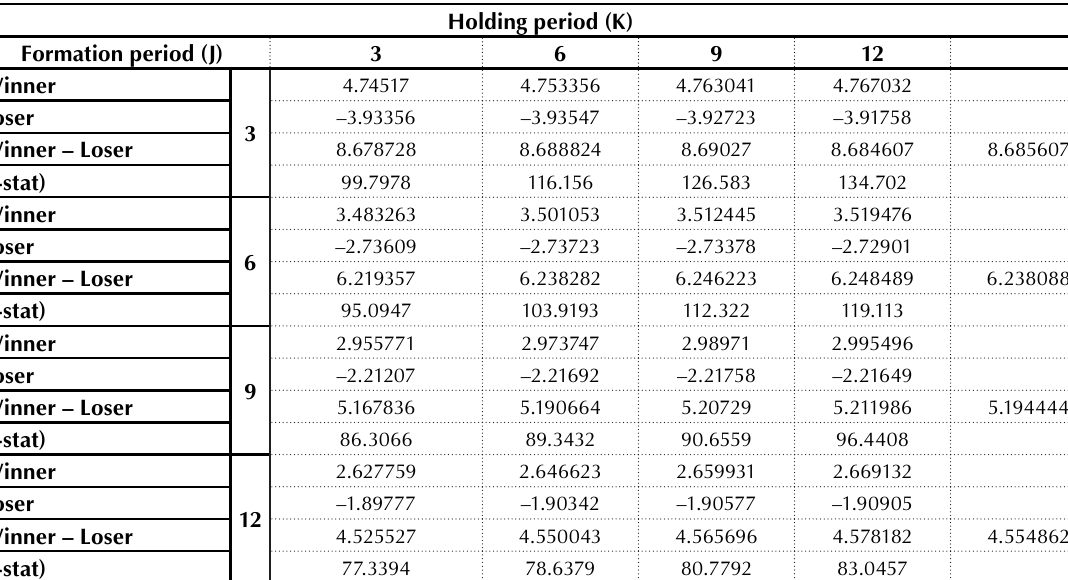
Table 2. Returns of weekly price momentum